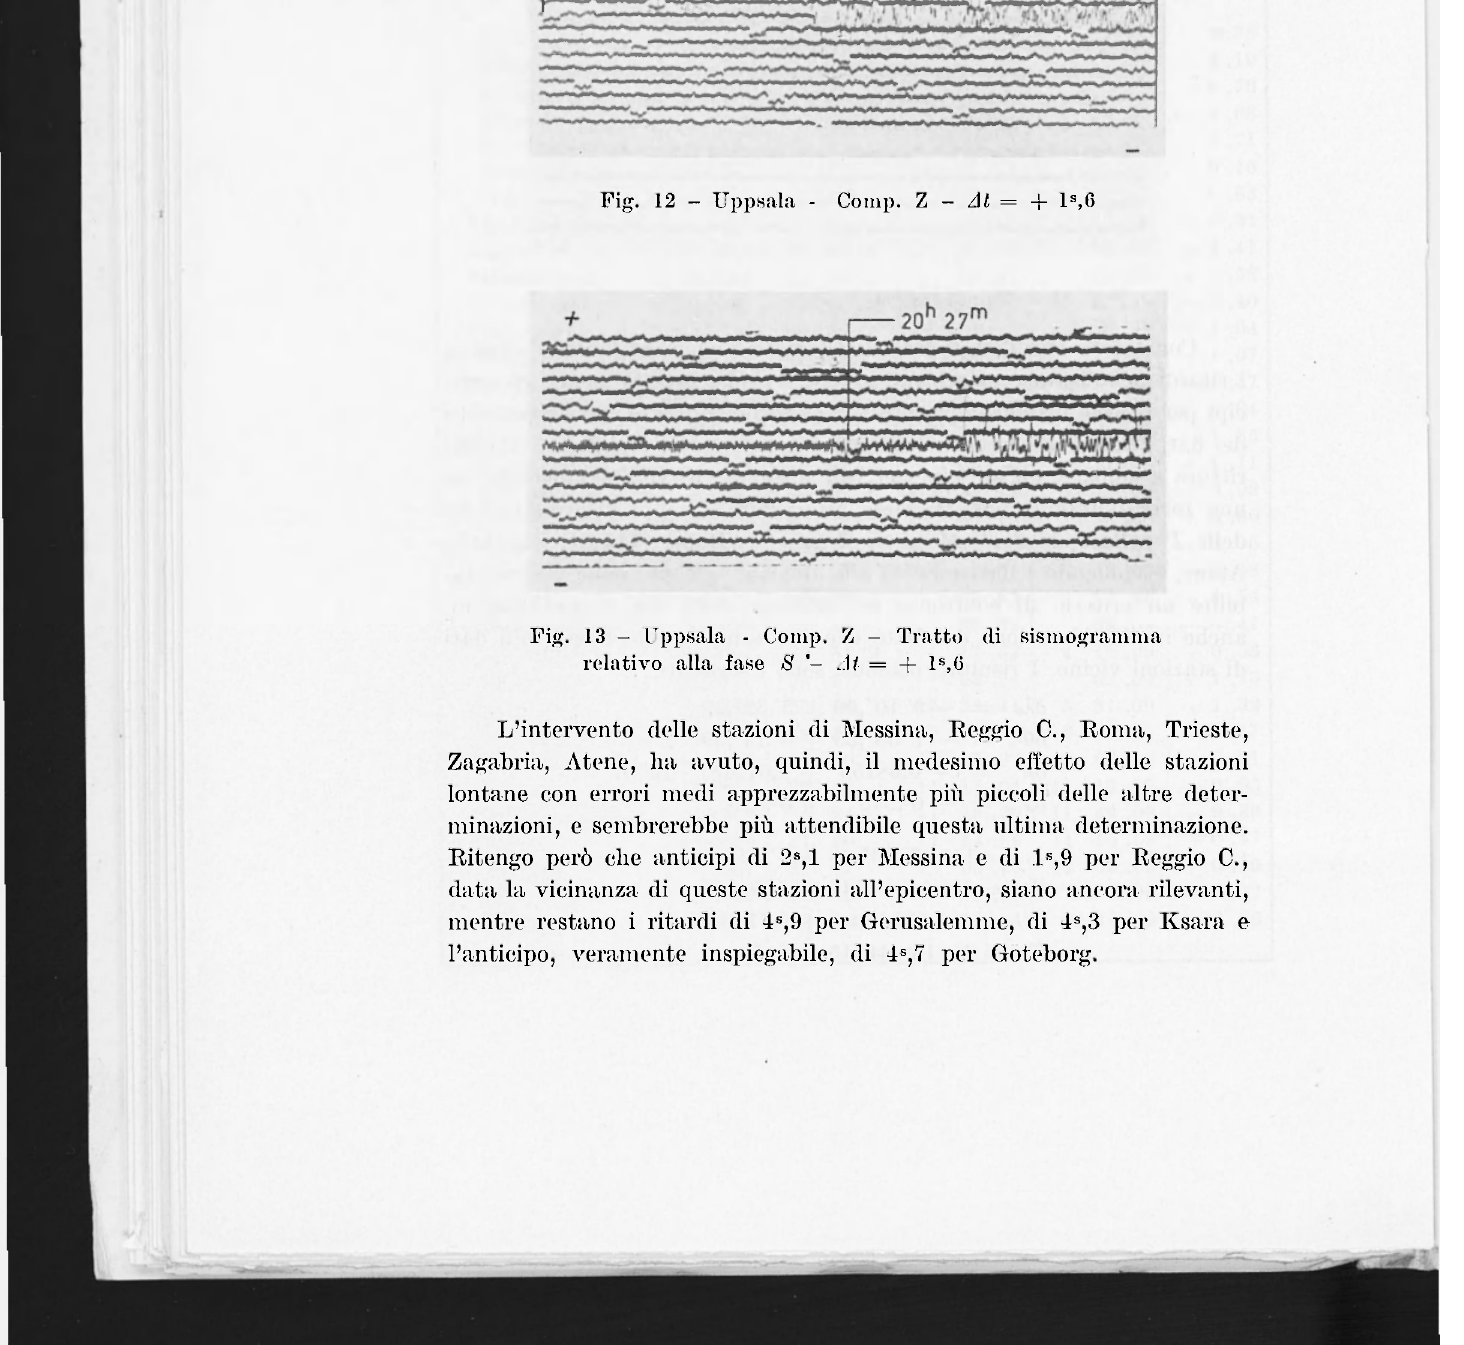
Fig. 12 - Uppsala - Comp. Z - At = + l s ,0